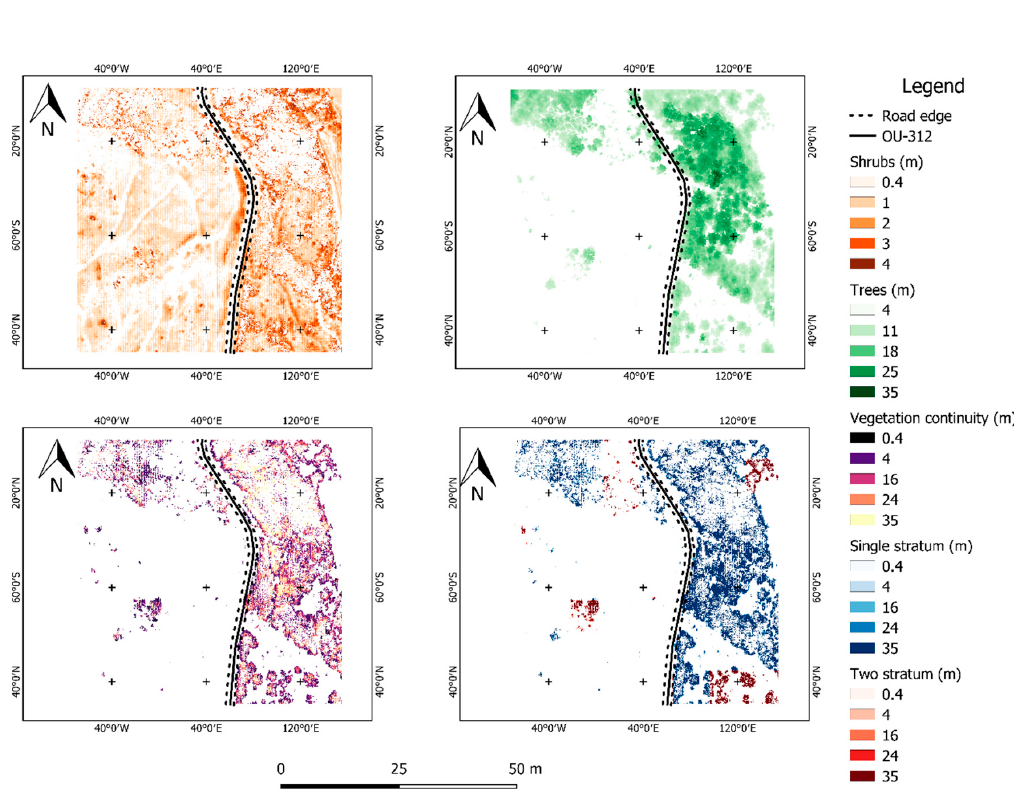
Figure 9. Areas of continuity of shrubs and its height.